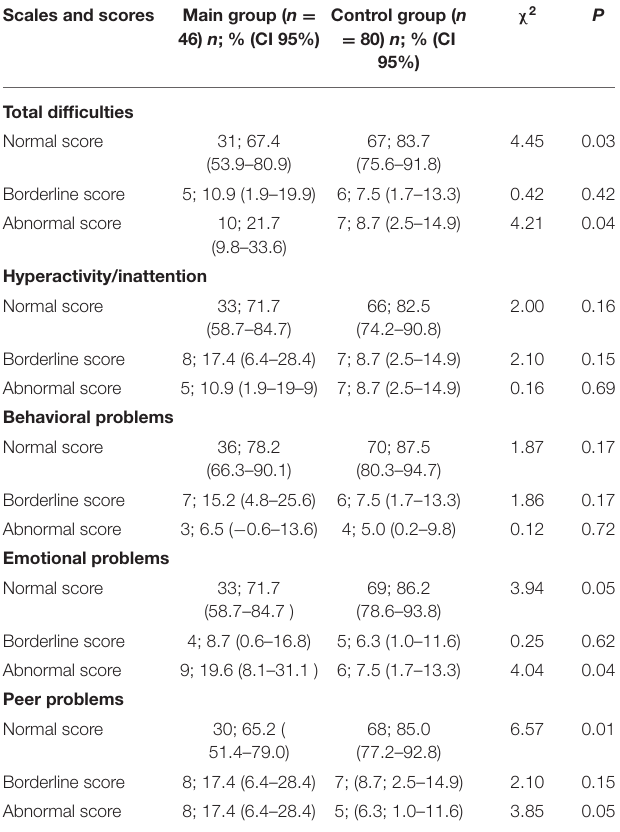
TABLE 2 | The frequency of psychosocial problems in the normal, borderline, and abnormal scores for the SDQ scales ( χ 2 test). Scales and